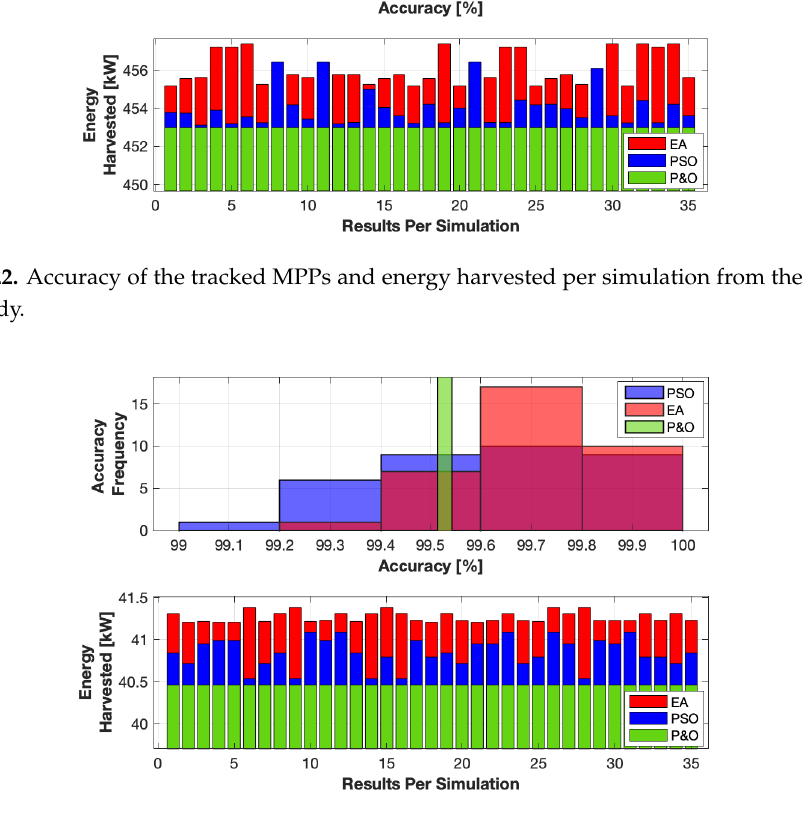
Figure 23. Accuracy of the tracked MPPs and energy harvested per simulation from the high power case